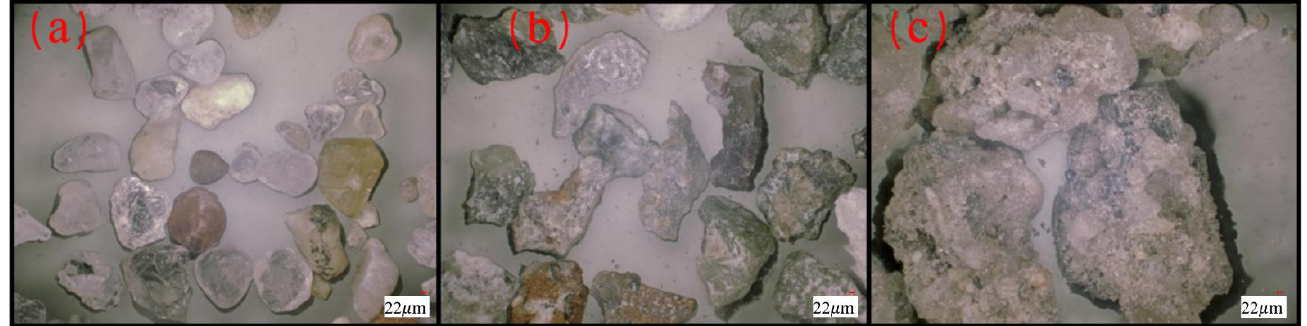
Figure 4. Ultra-deep field body microscopy images of materials: ( a ) washed SSTS with particle size of 0.3 – 0.6 mm, ( b ) washed M-S with particle size in 0.3 – 0.6 mm, and ( c ) unwashed SSTS with particle size over 1.18 mm.